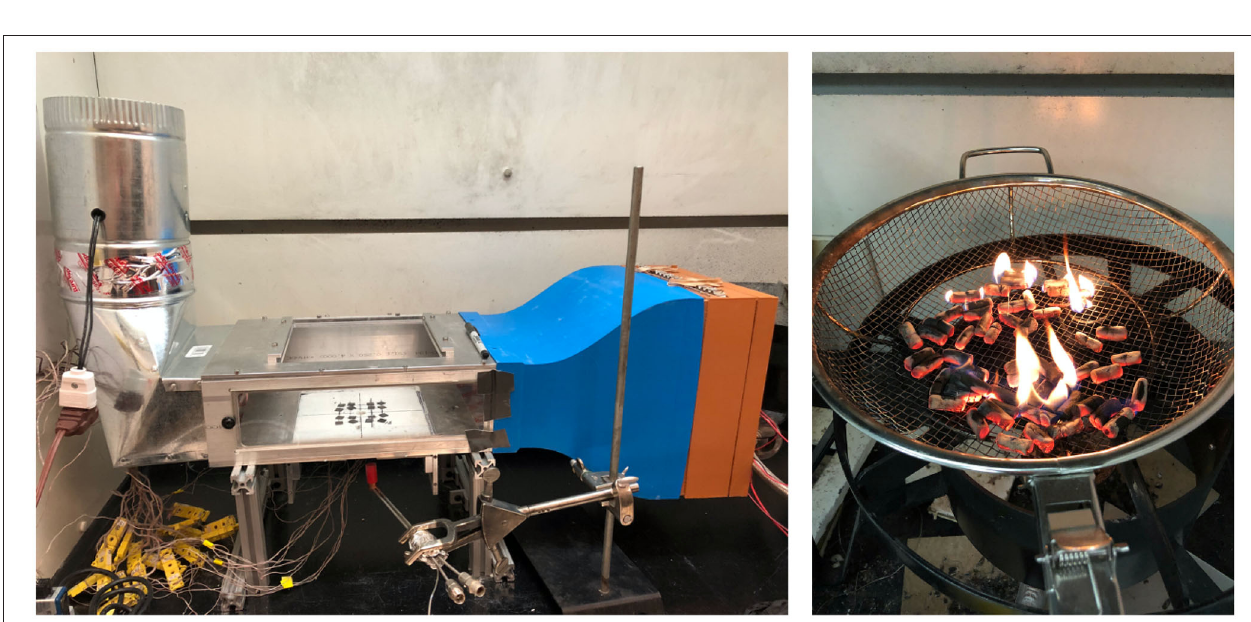
FIGURE 2 | Photograph of the experimental setup (left) with an inert sensor array mounted and (right) a photograph showing cylindrical brands just before flames die out and firebrands are deposited on the test surface.